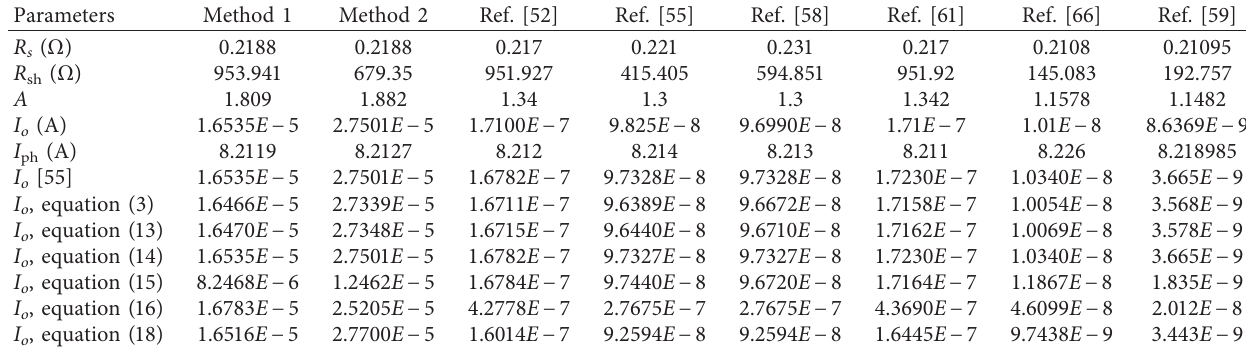
Table 8: Calculated parameters and data from simulations for KC200GT.